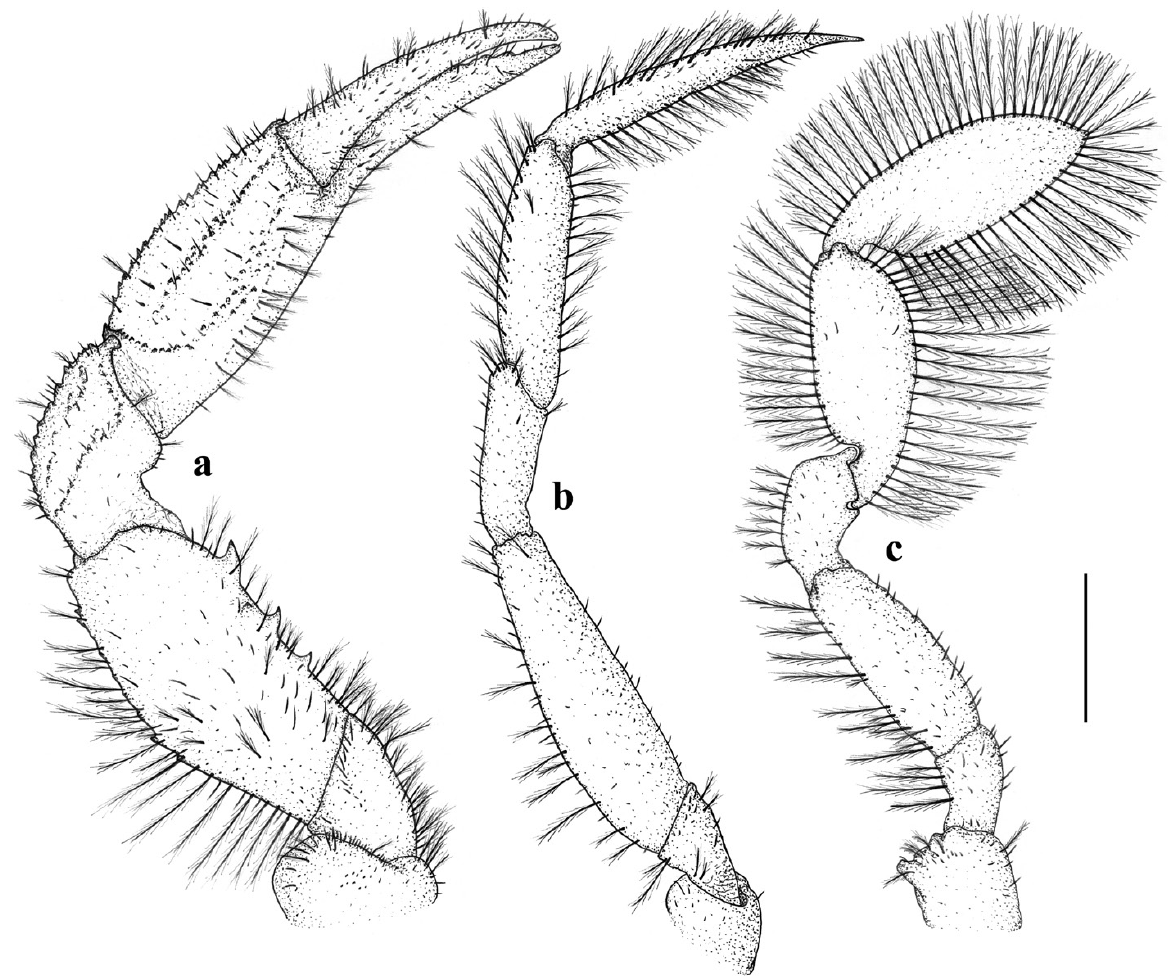
Figure 4 - Callinectes danae . 1 st undifferentiated stage: A , cheliped; B , 3 rd pereopod; C , 5 th pereopod. Scale: